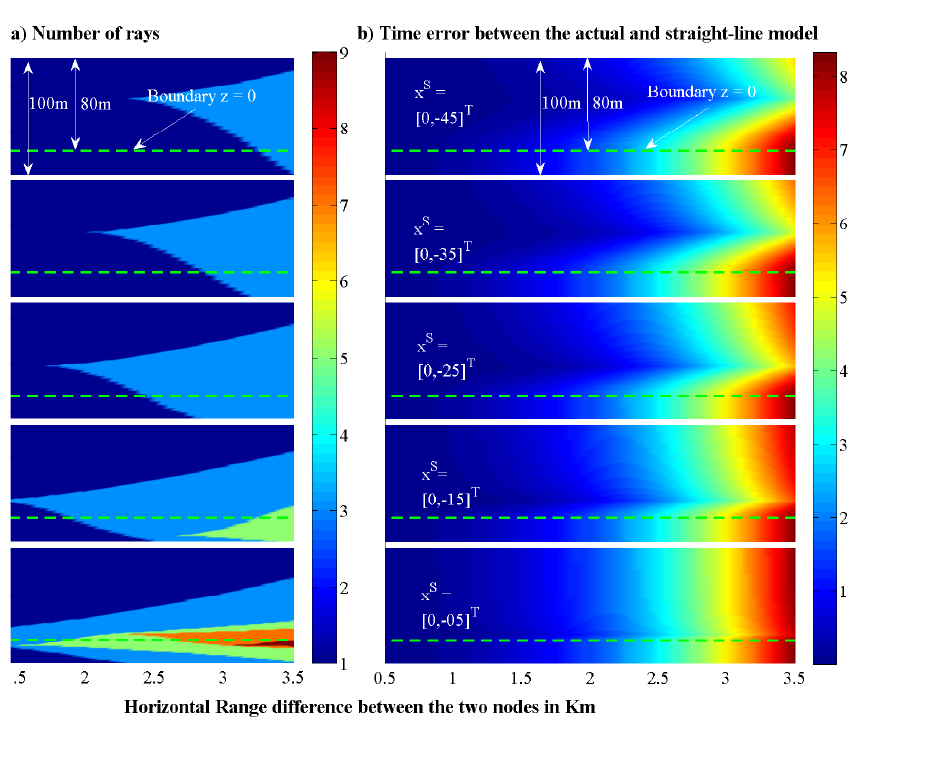
Figure 5. ( a ) Number of paths versus the location of the two nodes. ( b ) Range error due to the linear approximation of the